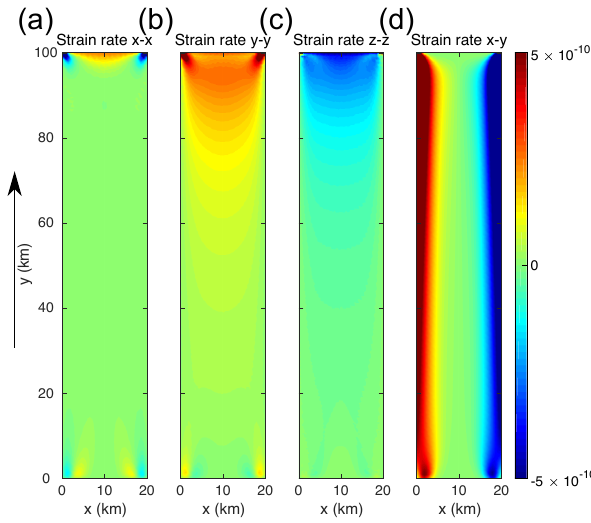
Figure 4. Rectangular ice shelf ESTAR higher-order steady-state surface strain rates (s − 1 ): (a) ˙ ε xx ; (b) ˙ ε yy , (c) ˙ ε zz ; and (d) ˙ ε xy